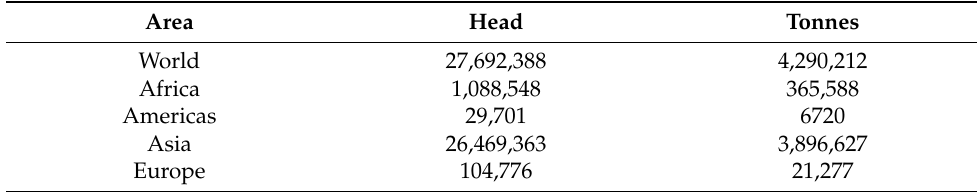
Table 1. Buffalo meat production